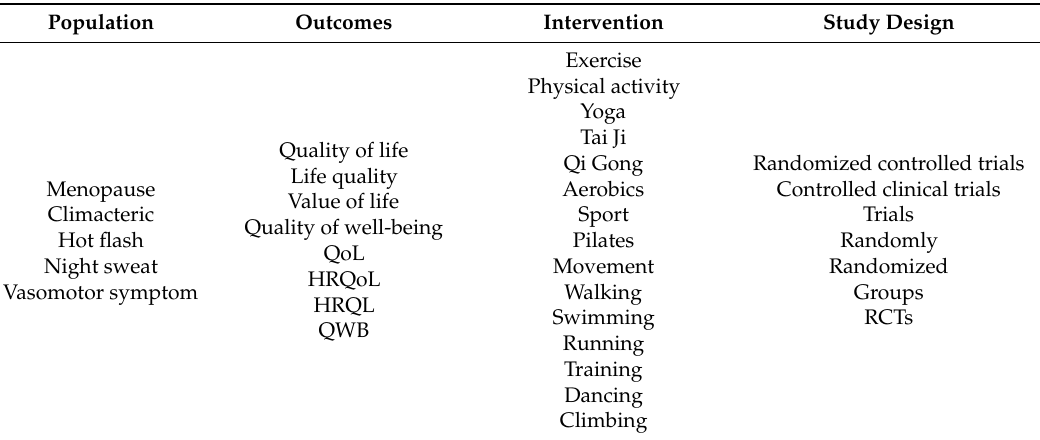
Table A1. Search terms